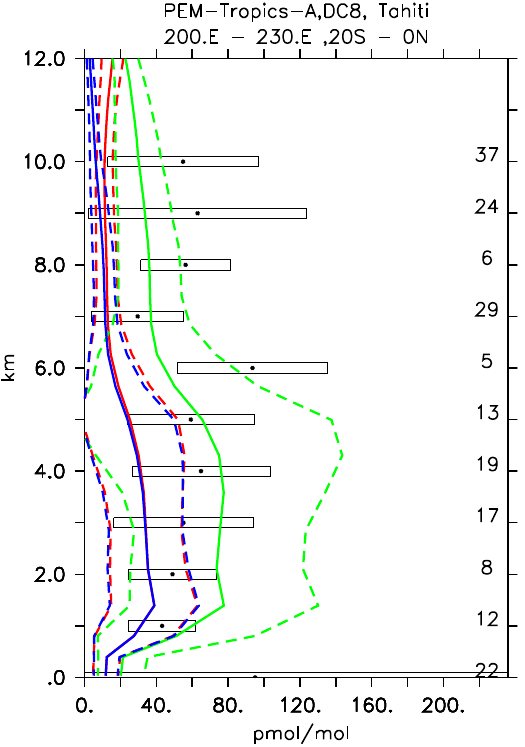
Fig. 6. Vertical profiles of CH 3 C(O)OH (nmolmol − 1 ) from simu- lations and observations. Asterisks and boxes represent the average and the standard deviation (with respect to space and time) of the measurements from a specific region (Tahiti) taken during the PEM Tropics-A campaign. On the right side the number of measurements for the specific region is listed. The simulated average is indicated by the line and the corresponding standard deviation with respect to time and space by the dashed lines. The blue, red and green lines represent model results from simulations SR1, SR2 and S0, respec-